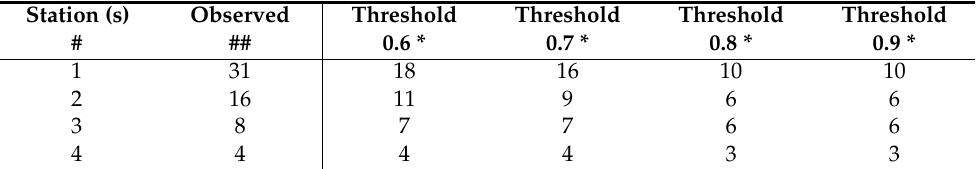
Table 3. The observed irrigation signals are obtained using daily in situ soil moisture and precipita- tion. Within various defuzzification thresholds, different irrigation signals are correctly extracted. The thresholds refer to the relevant degree between increased soil moisture and irrigation. Station (s) Observed Threshold